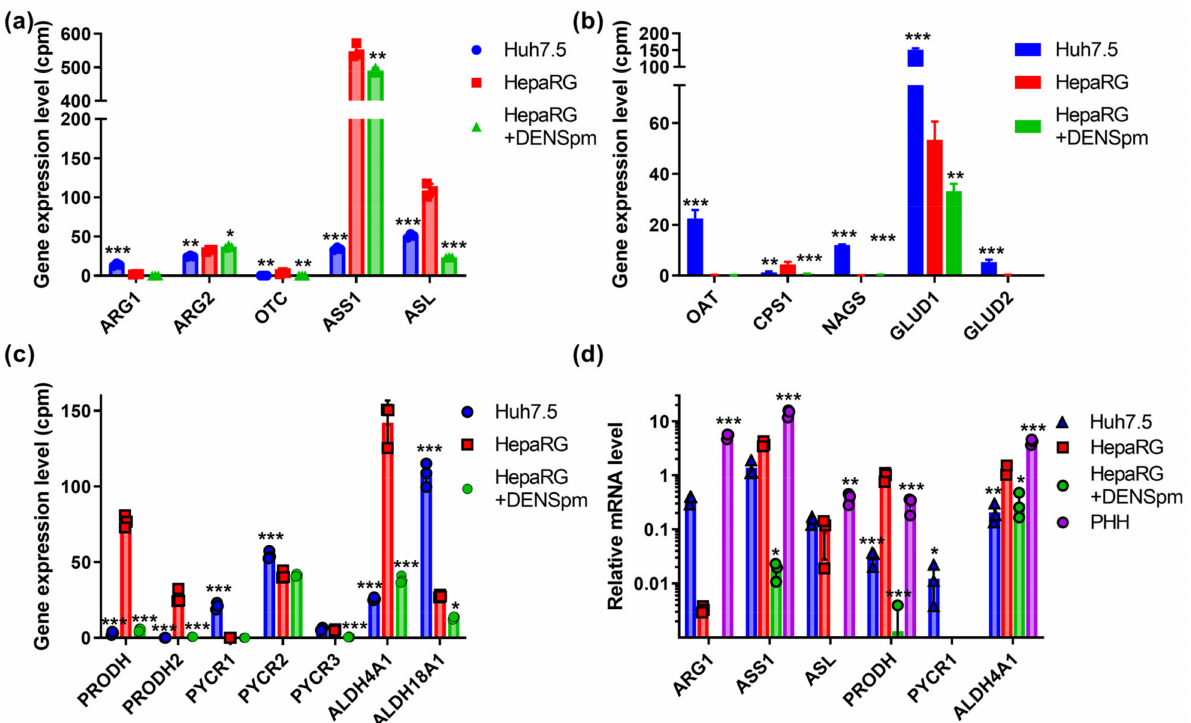
Figure 5. Relative mRNA levels of urea cycle and proline metabolizing enzymes in hepatoma Huh7.5 cells, hepatocyte-like HepaRG cells, and HepaRG cells treated with DENSpm, assessed by RNAseq analysis. Levels of the mRNA of the encoding enzymes of the urea cycle ( a ) or of the proline metabolism ( b , c ). ( d ) Relative levels of mRNA of metabolic genes in these cells and PHH assessed by RT-qPCR and normalized to the levels of GUS mRNA. Bars are means ± S.D. Statistical